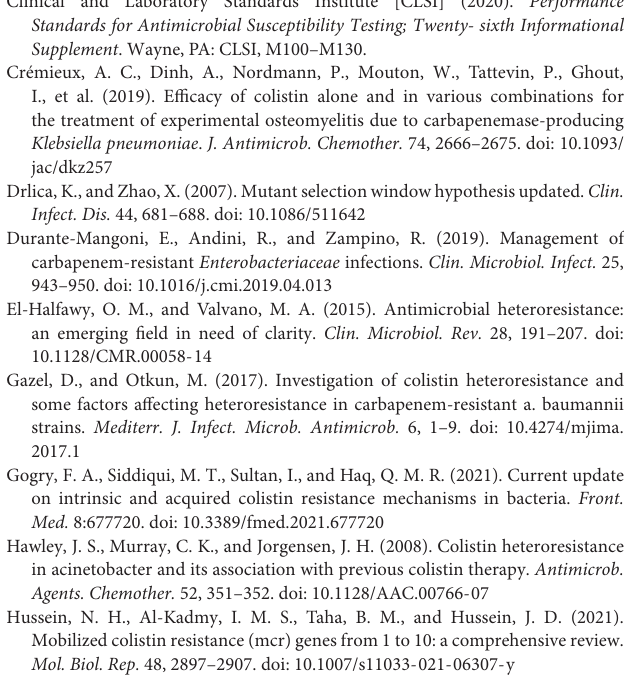
Supplementary Figure 1 | Phylogenetic tree and growth curves of K65 and four resistant clones. (A) Phylogenetic tree of K65 and four resistant clones (C1–C4) constructed by comparsion with 31 house-keeping genes ( dnaG, frr, infC, nusA, pgk, pyrG, rplA, rplB, rplC, rplD, rplE, rplF, rplK, rplL, rplM, rplN, rplP, rplS, rplT, rpmA, rpoB, rpsB, rpsC, rpsE, rpsI, rpsJ, rpsK, rpsM, rpsS, smpB, and tsf ). (B) Growth curves of Kp65 and 4 resistant clones for 24